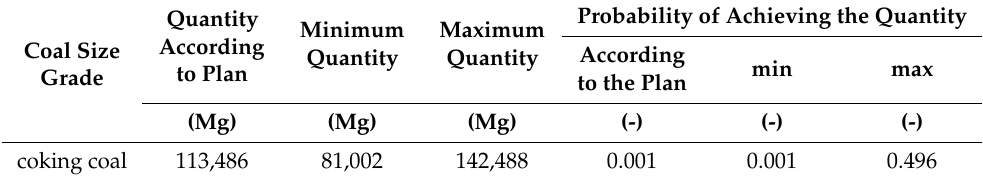
Table A11. A summary of the volumes of sales of the individual coal grades with the probability of their achievement at σ yprog for mine “B”.